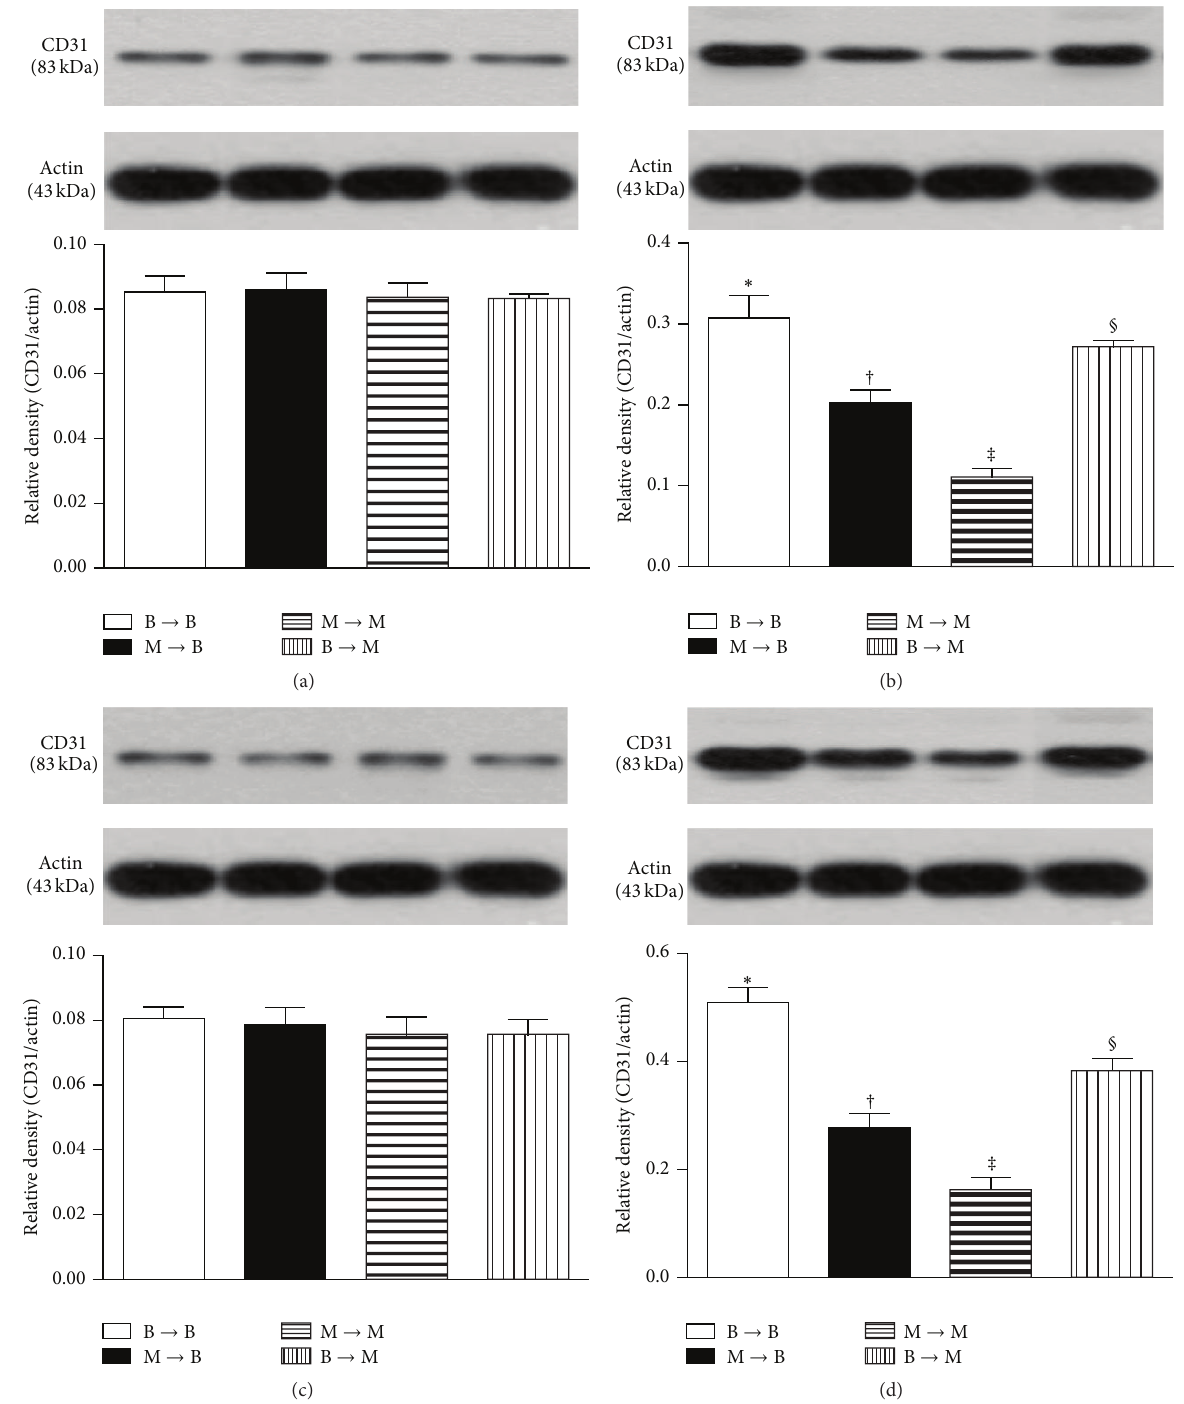
Figure 12: Protein expression of CD31 in ischemic quadriceps at day 14 after critical limb ischemia (CLI) induction ( 𝑛 = 6 ). (a) At sham control (SC) treatment condition, CD31 did not differ among four groups, 𝑝 = 1.0 . (b) At CLI subgroup, groups with different symbols ( ∗ , † , ‡ , and §), 𝑝 < 0.05 . (c) At SC + tPA treatment condition, CD31 did not differ among four groups, 𝑝 = 1.0 . (d) At CLI + tPA subgroup, groups with different symbols ( ∗ , † , ‡ , and §), 𝑝 < 0.05 . All statistical analyses were performed by one-way ANOVA followed by Bonferroni multiple comparison post hoc test. tPA = tissue plasminogen activator. 𝑛 = 6 for each